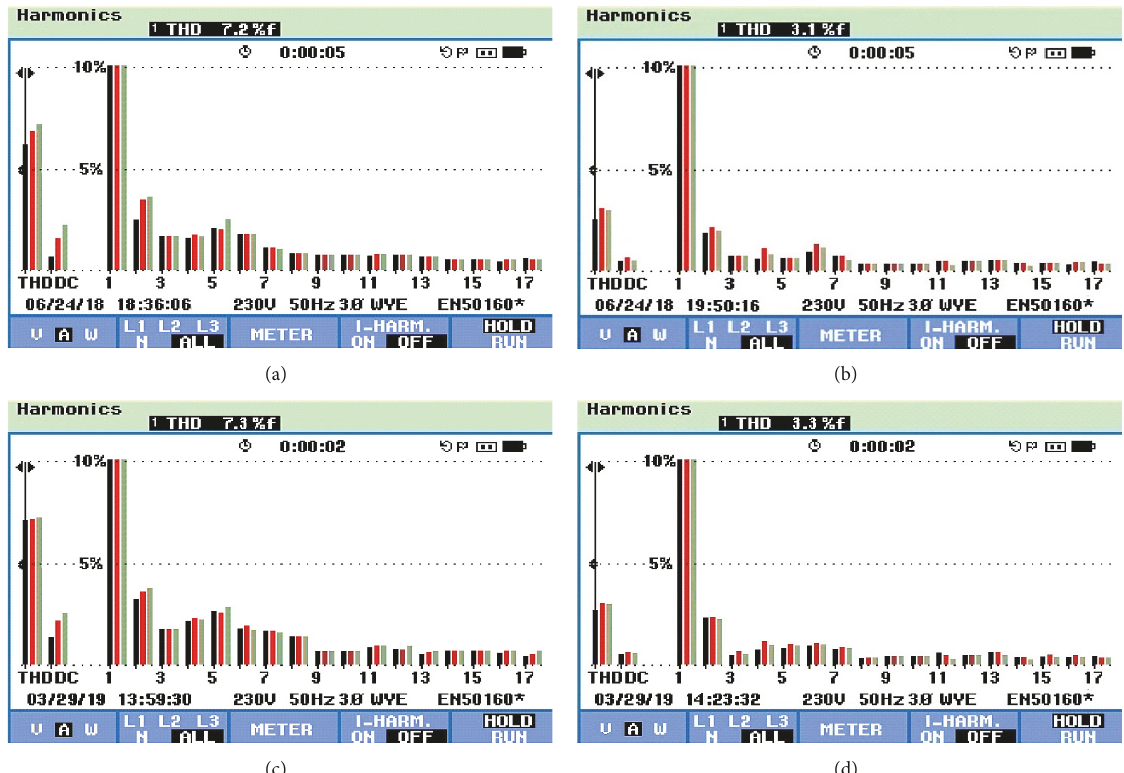
Figure 16: THD of the three-phase grid current: (a) the conventional MPVC, (b) the proposed MPVC, (c) the conventional MPCC, and (d) the proposed